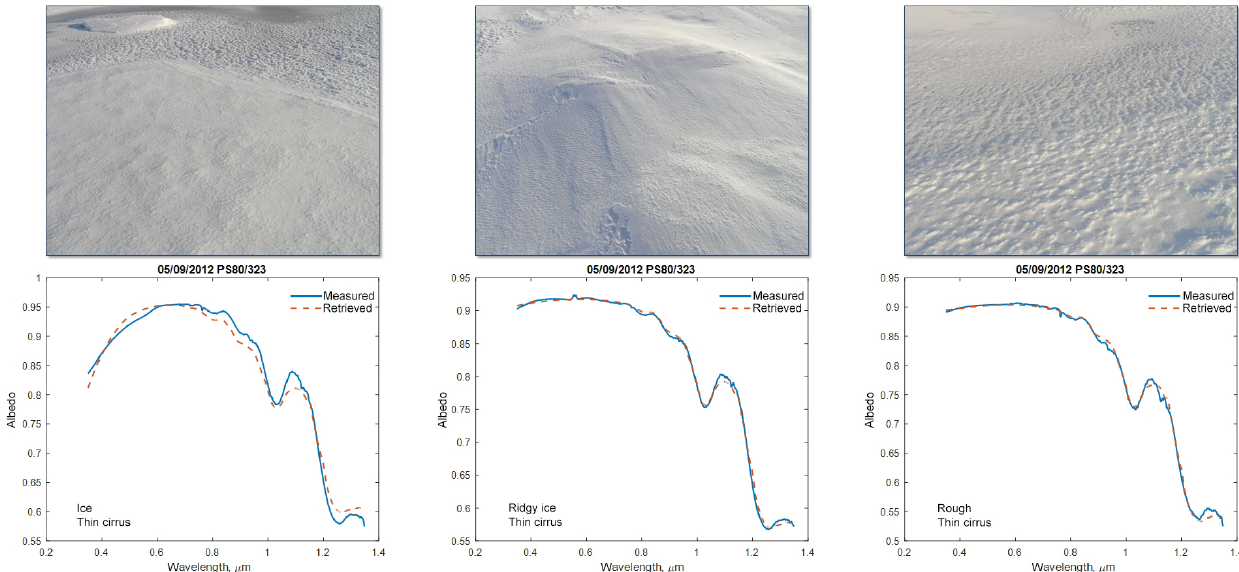
Figure 11. Snow-covered ice. The surface is fresh fallen fine-grained snow (up to 5cm, 2.4cm on average) on the wind-crusted older scattering layer (2–4cm). The average air temperature is − 3.2 ◦